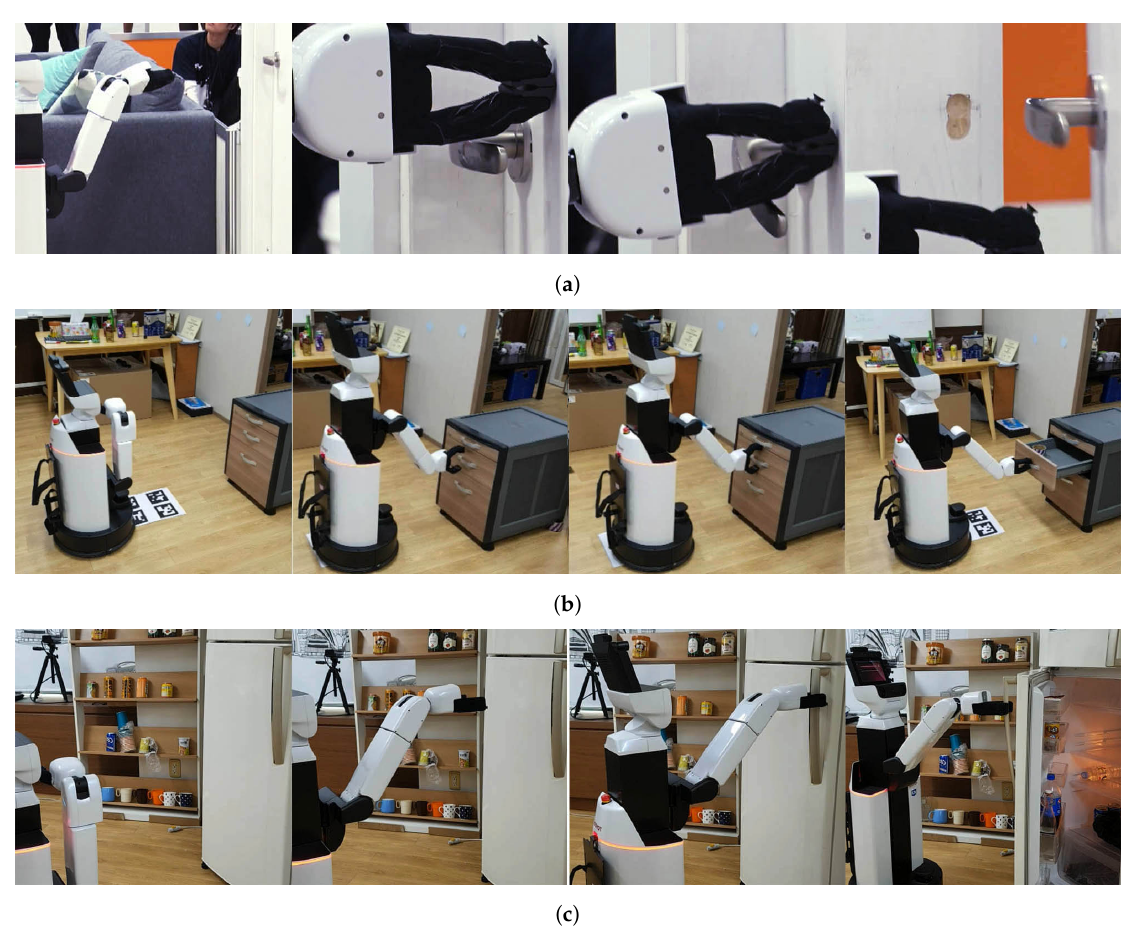
Figure 11. Whole body manipulation examples. ( a ) Opening a Door, ( b ) Opening a Drawer and ( c ) Opening a